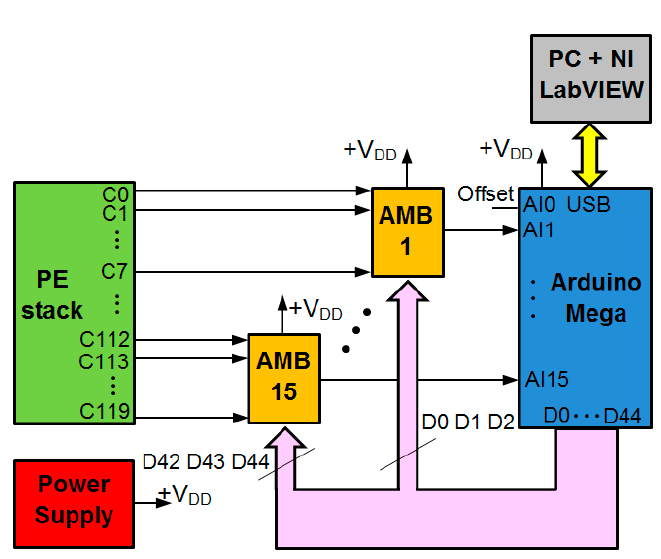
Figure 3. Developed monitoring system architecture.